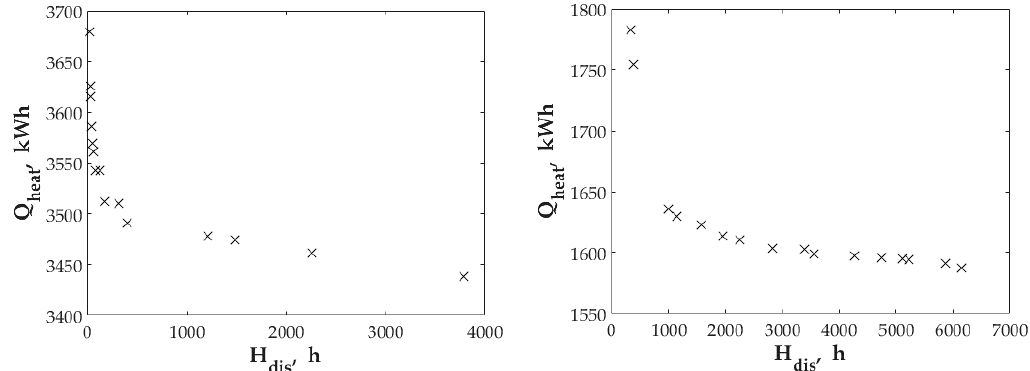
Figure 6. The comparison of Pareto front for W O10 -B std -Kat- and W O10 -B pass -Kat A2 .